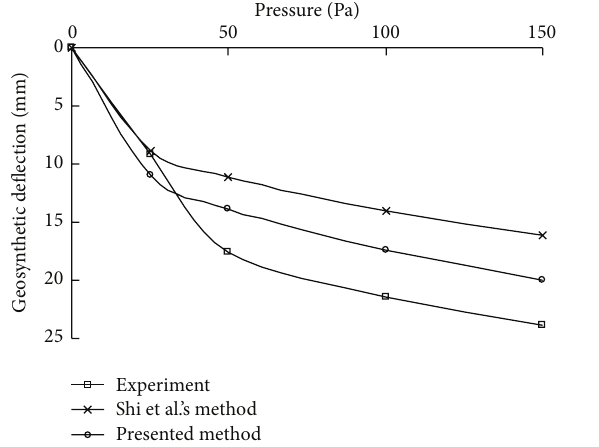
Figure 13: Comparison of deflections along the edge.